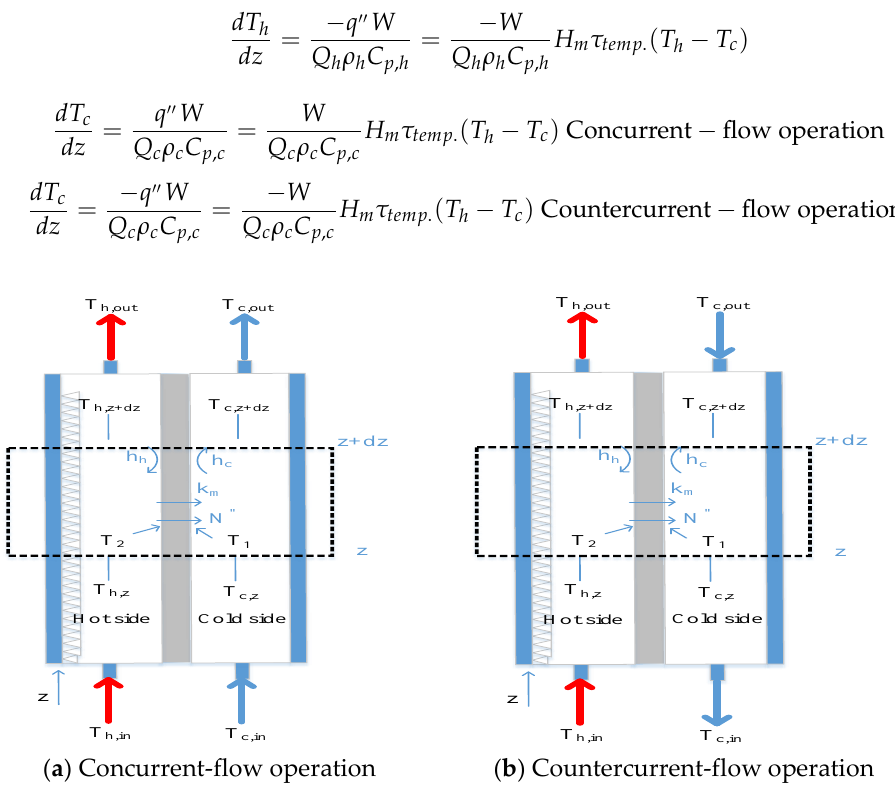
Figure 6. The energy balance made within a finite fluid element (concurrent-flow operations).